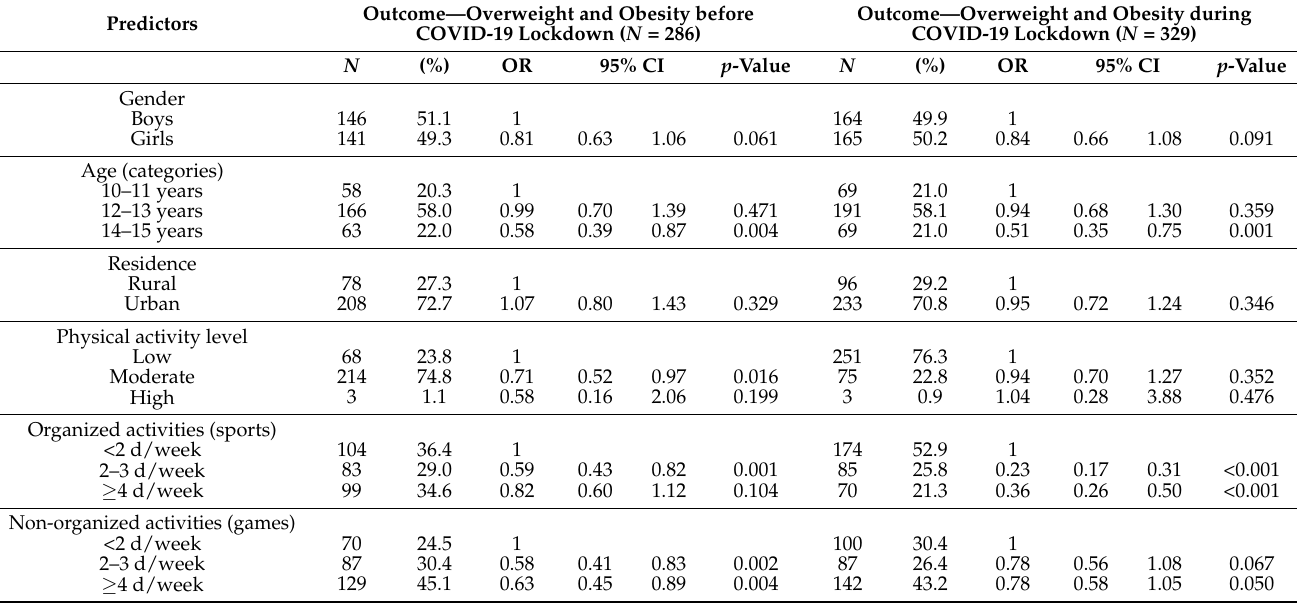
Table 4. Association of participants’ characteristics and lifestyle habits to overweight and obesity before and during COVID-19